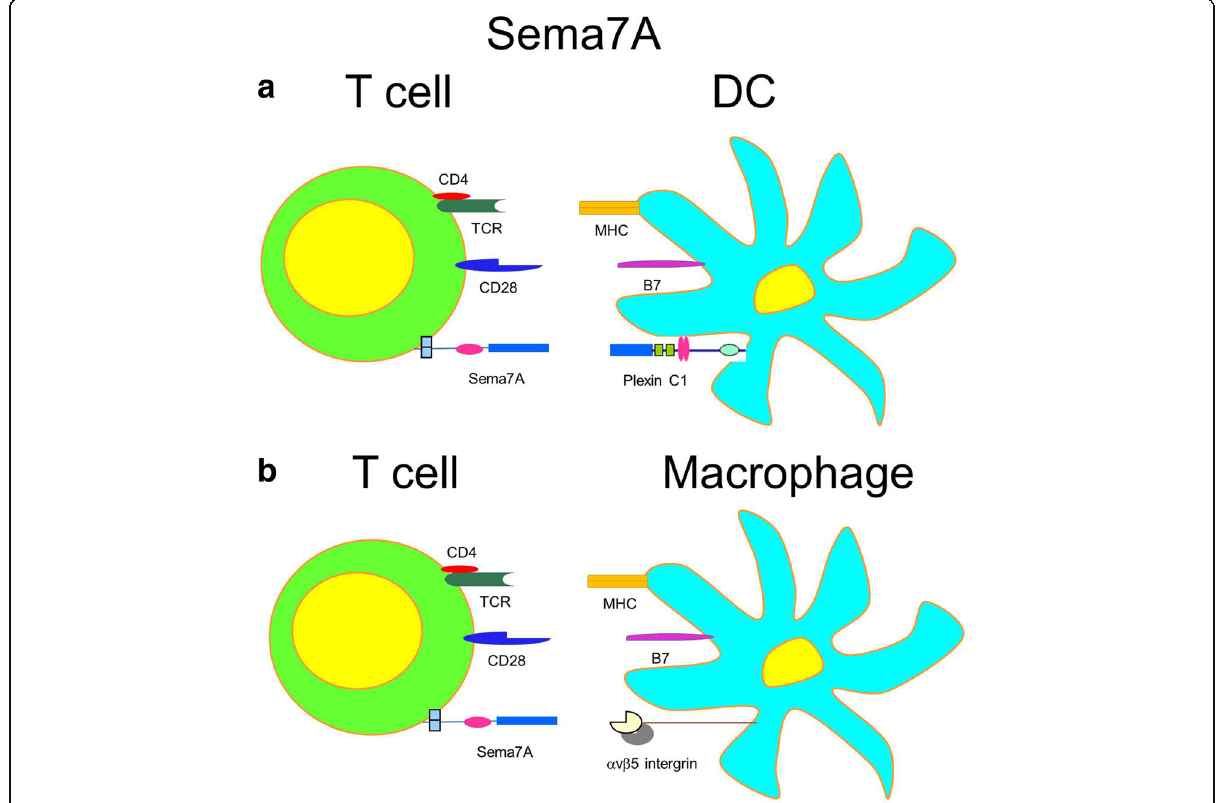
Fig. 6 T cell inducibly expressed Sema7A has distinct receptor-dependent effects on DC and macrophages. a Sema7A in T cell-DC interaction. Indirect T cell stimulation by T cell expressed Sema7A ligation of Plexin C1 on DC. b Sema7A in T cell-macrophage interaction. Inflammatory macrophages get activated and stimulated for pro-inflammatory cytokine secretion by Sema7A ligation of α 1 β 1